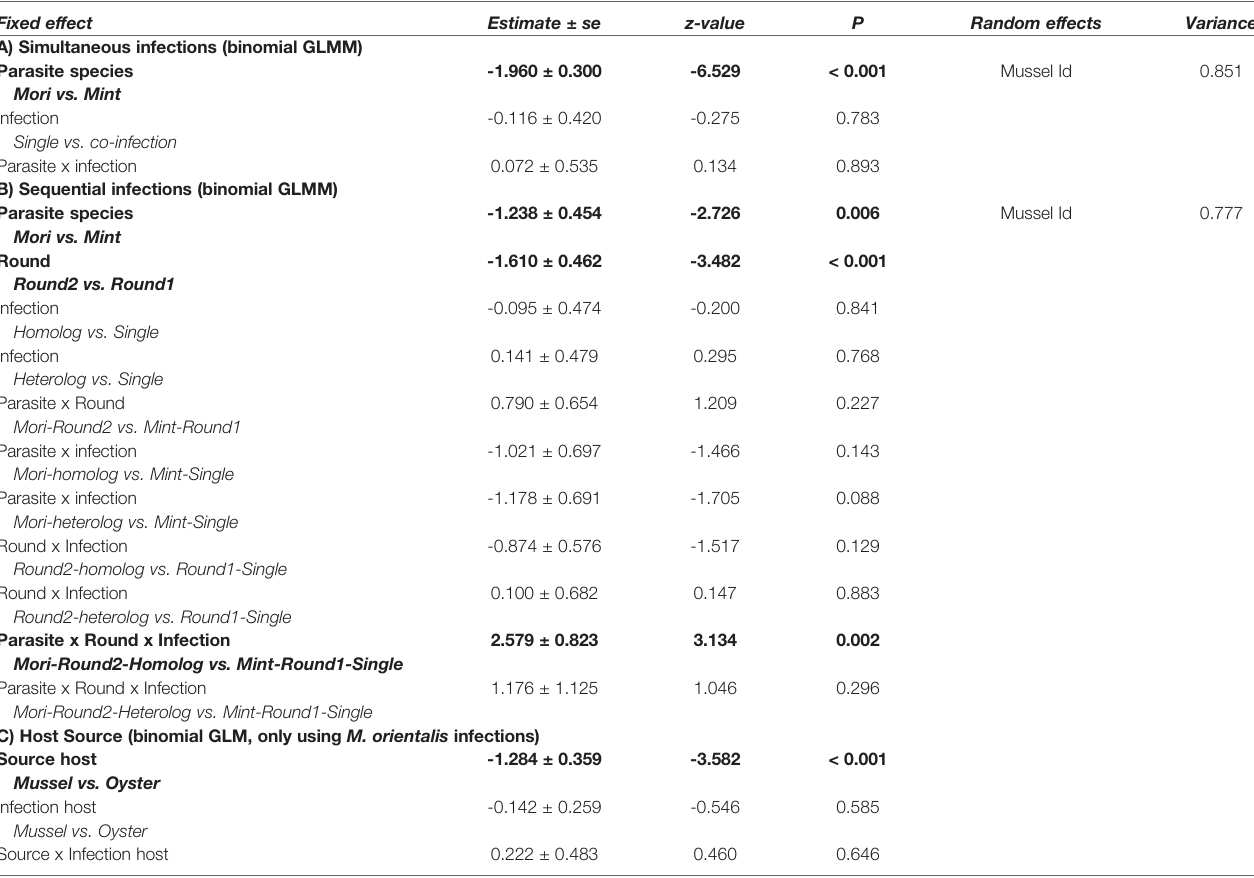
TABLE 1 | Generalized linear (GLM) and Generalized linear mixed model (GLMM) model